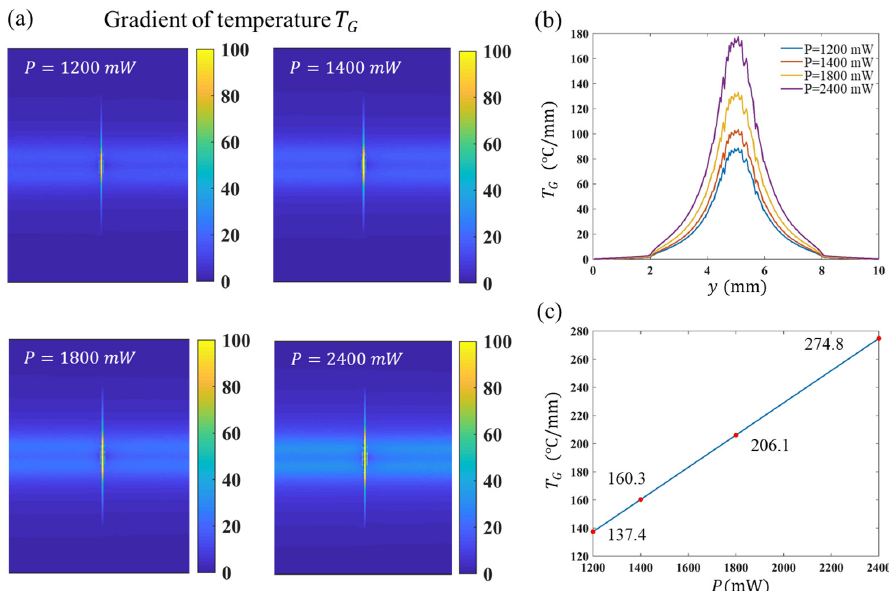
Figure 8. Crack detection at different laser effective power ( v = 10 mm/s, f = 50 Hz): ( a ) superposition results of ∆ T ; ( b ) linear fitting relationship between P and the maximum of T G ; ( c ) the distribution of T G along crack Center ( T G ≥ 0